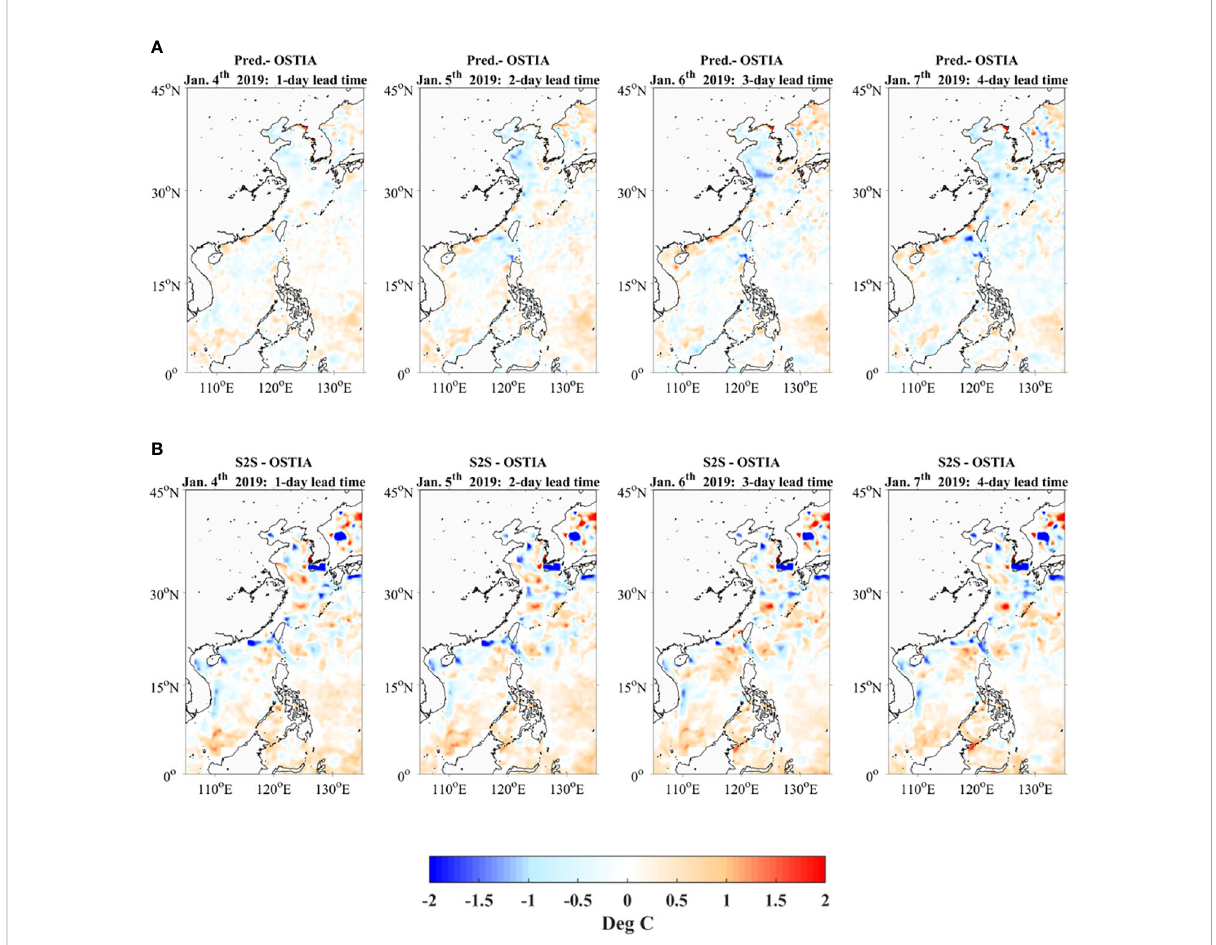
FIGURE 6 The spatial distribution of SST difference between (A) predicted SSTs and OSTIA and (B) S2S and OSTIA from January 4 th to 10 th ,